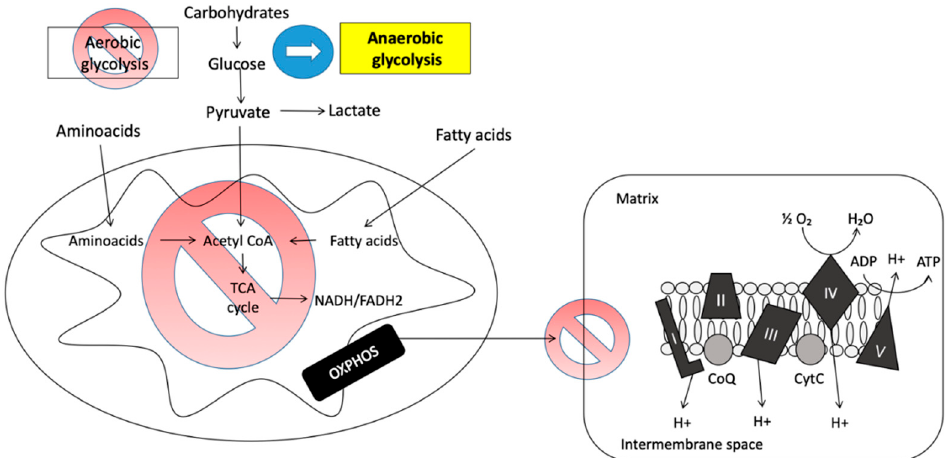
Figure 3. Mitochondrial anaerobiosis state during mitochondrial dysfunction. ADP, adenosine diphosphate; ATP, adenosine triphosphate; I, complex I; II, complex II; III, complex III; IV, complex IV; V, complex V; CoQ, coenzyme Q; CytC, cytochrome C; FADH, flavin and adenine dinucleotide hydrogen; H+, proton; NADH, nicotinamide adenine dinucleotide hydrogen; OXPHOS, oxidative phosphorylation system; TCA, tricarboxylic acid.